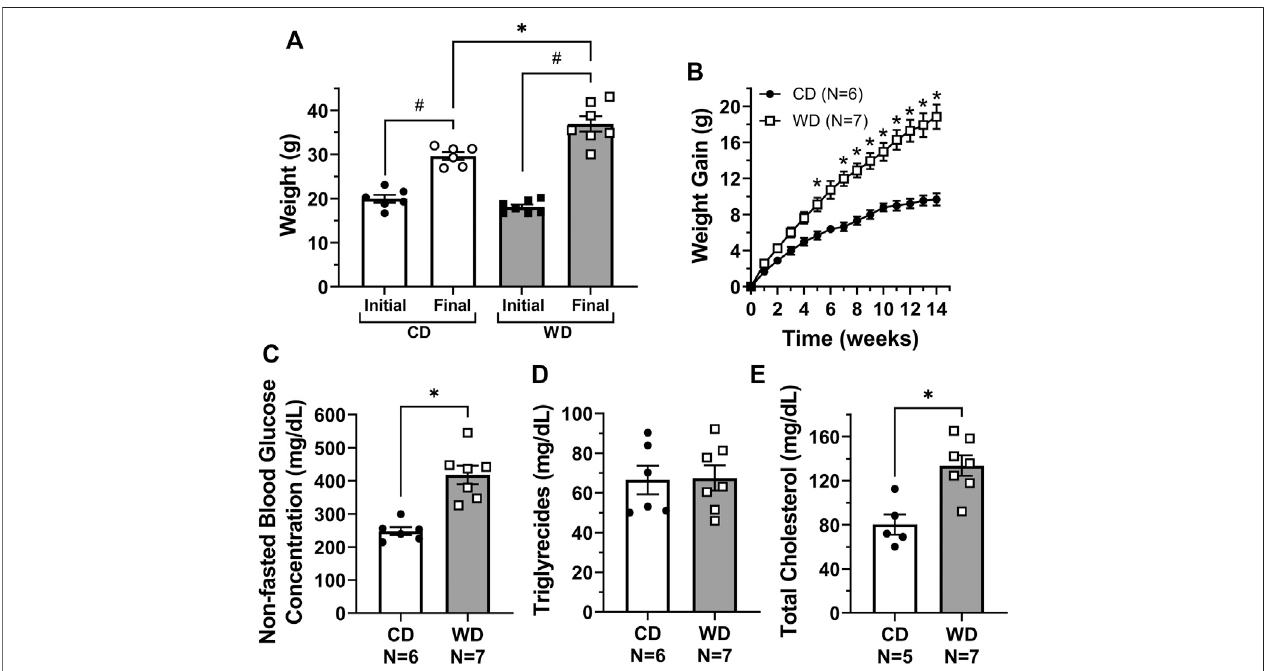
FIGURE1| Feedingofawesterndietfor14 weeksinducedobesityandincreasedplasmaglucoseandcholesterollevels. (A) Initialand fi nalbodyweightforcontrol diet(CD)andwesterndiet(WD)groups; (B) overallgaininbodyweightperweekoverthe14-weektreatmentperiod;and (C – E) non-fastedplasmaglucose,triglycerides, andtotalcholesterolconcentration(inmg/dL)forCDandWDgroups,respectively.InpanelE,cholesterollevelscouldnotbemeasuredinonesamplefromtheCDgroup duetolimitedsample.Dataispresentedasmean±SEM.Statisticallysigni fi cantdifferenceswereevaluatedusingttestsfordatainpanelsA,andC – E,andtwo-way ANOVA with Š ídák post hoc test for data in panel B. # p < 0.05 for initial vs. fi nal weights, * p < 0.05 for CD vs. WD.